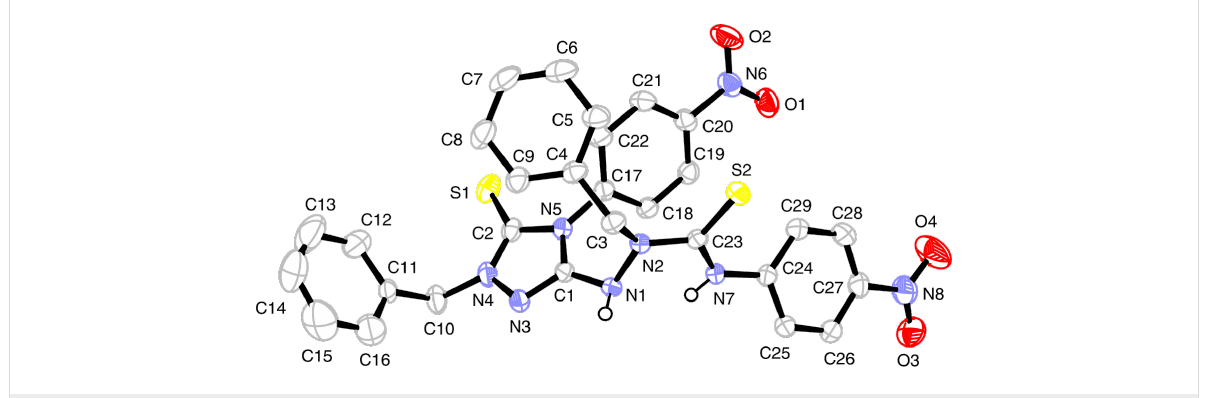
Figure 4: Solid-state structure of 10b . Thermal displacement ellipsoids are drawn at the 30% probability level. Selected bond lengths (Å): C2–S1 1.664(2), C2–N4 1.346(3), C2–N5 1.382(3), N3–N4 1.381(3), C1–N1 1.388(3), C1–N3 1.298(2), C1–N5 1.374(2), C23–S2 1.672(2), C23–N2 1.377(2), C23–N7 1.353(3). Hydrogen bonds: a) N1···N7: N7–H 0.84 Å, N7···N1 2.584 Å, H···N1 2.12 Å,